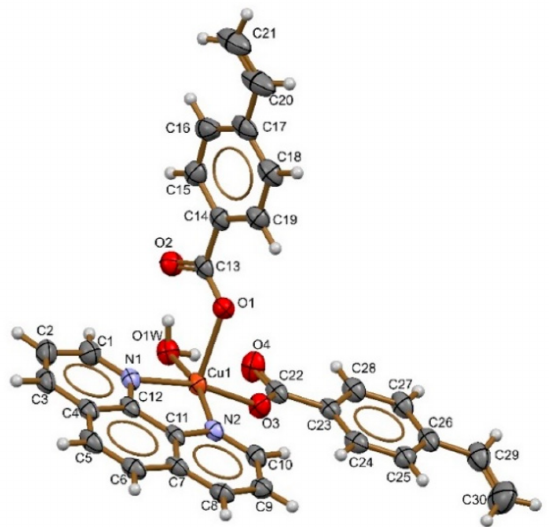
Figure 1. Ortep diagram of functional monomer [Cuphen(VBA) 2 H 2 O] ellipsoids at 50% of probability. The major deviations of the atoms are 0.0213 Å, whereas the O(3) and the O(1W), which are also forming part of the pyramid base, are about 0.0877(2) and 0.0517(2) Å above the plane. At the apical position of the pyramid, a second vinylbenzoate anion is coordinated, with Cu—O(1) = 2.2623(16) Å, a distance similar to that observed in related compounds of 2.2623(16)